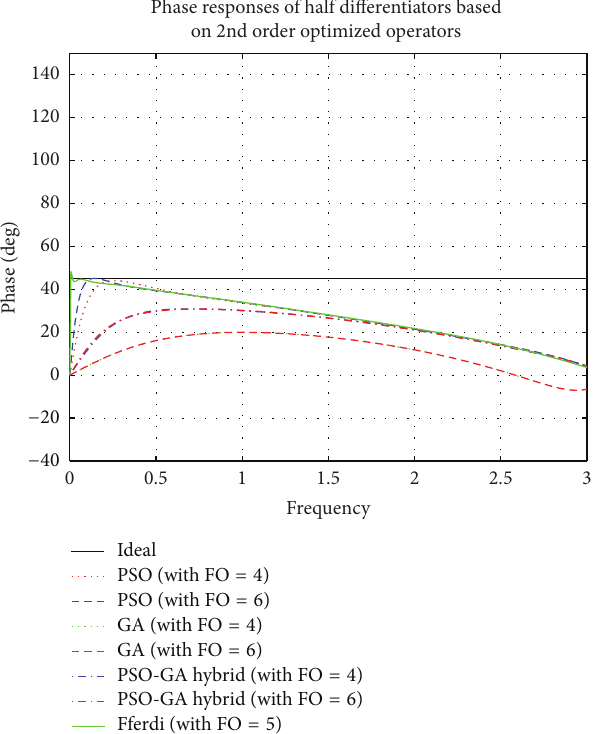
Figure 9: Comparison of magnitude responses of proposed half differentiators based on 3rd order optimized differential